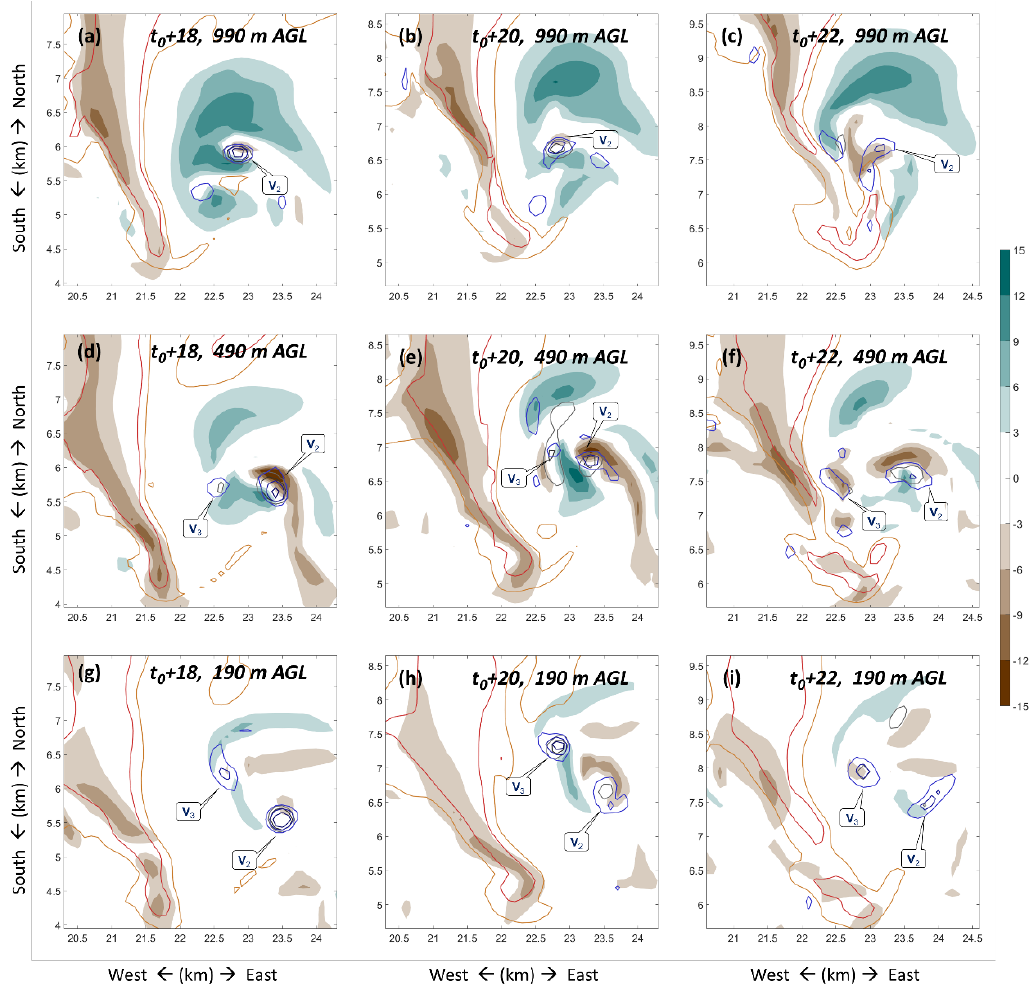
Figure 10. Horizontal cross-section of the simulated supercell and tornado in the second near-surface vorticity replacement during the tornado demise stage at the height of ( a − c ) 990 m, ( d − f ) 490 m and ( g − i ) 190 m AGL at (left column) t 0 + 18 min, (middle column) t 0 + 20 min and (right column) t 0 + 22 min. Vertical velocity is given by shaded contours. Reflectivity of 40 (50) dBZ is given by orange (red) contours. Vertical vorticity of 0.05, 0.1 and 0.15 s − 1 is given by blue contours. Pressure perturbation of − 1.5 and − 2 hPa is given by dark grey contours. V 2 and V 3 denote the second and third tornadic vortices,